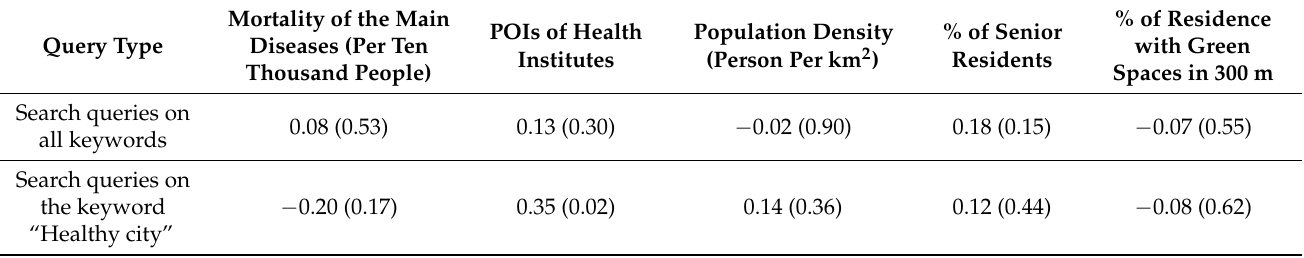
Table 5. Spearman correlation coefficients and the p -values (values in parenthesis) between the search queries and the demographic, environmental, and health factors at the subdistrict